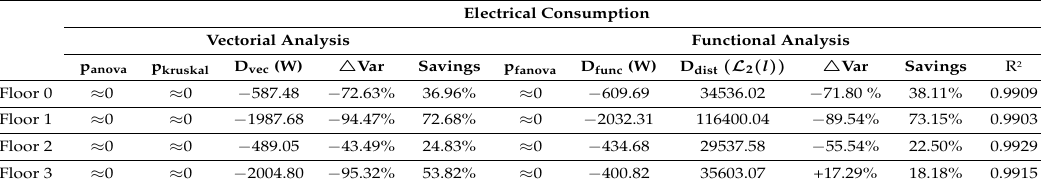
Table 2. Numerical results on each floor for lighting consumption. The vectorial results are presented with D v measuring the difference between medians. The functional results, accompanied with the average minute difference (D func ), the L 2 ( l ) distance between the mean functions (D dist ) and the smoothing adjustment (R 2 ), are also presented. For both analyses, the change in the variability of the data ( (cid:52) Var) and the electrical savings are displayed. Lastly, the p -values for the tests, both vectorial and functional, are displayed in this table.